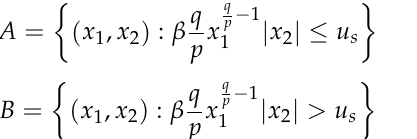
Figure 3. Singular and nonsingular areas ( u s = 2, q = 3, p = 5). Reprinted with permission from ref. [86]. 2013 Elsevier.